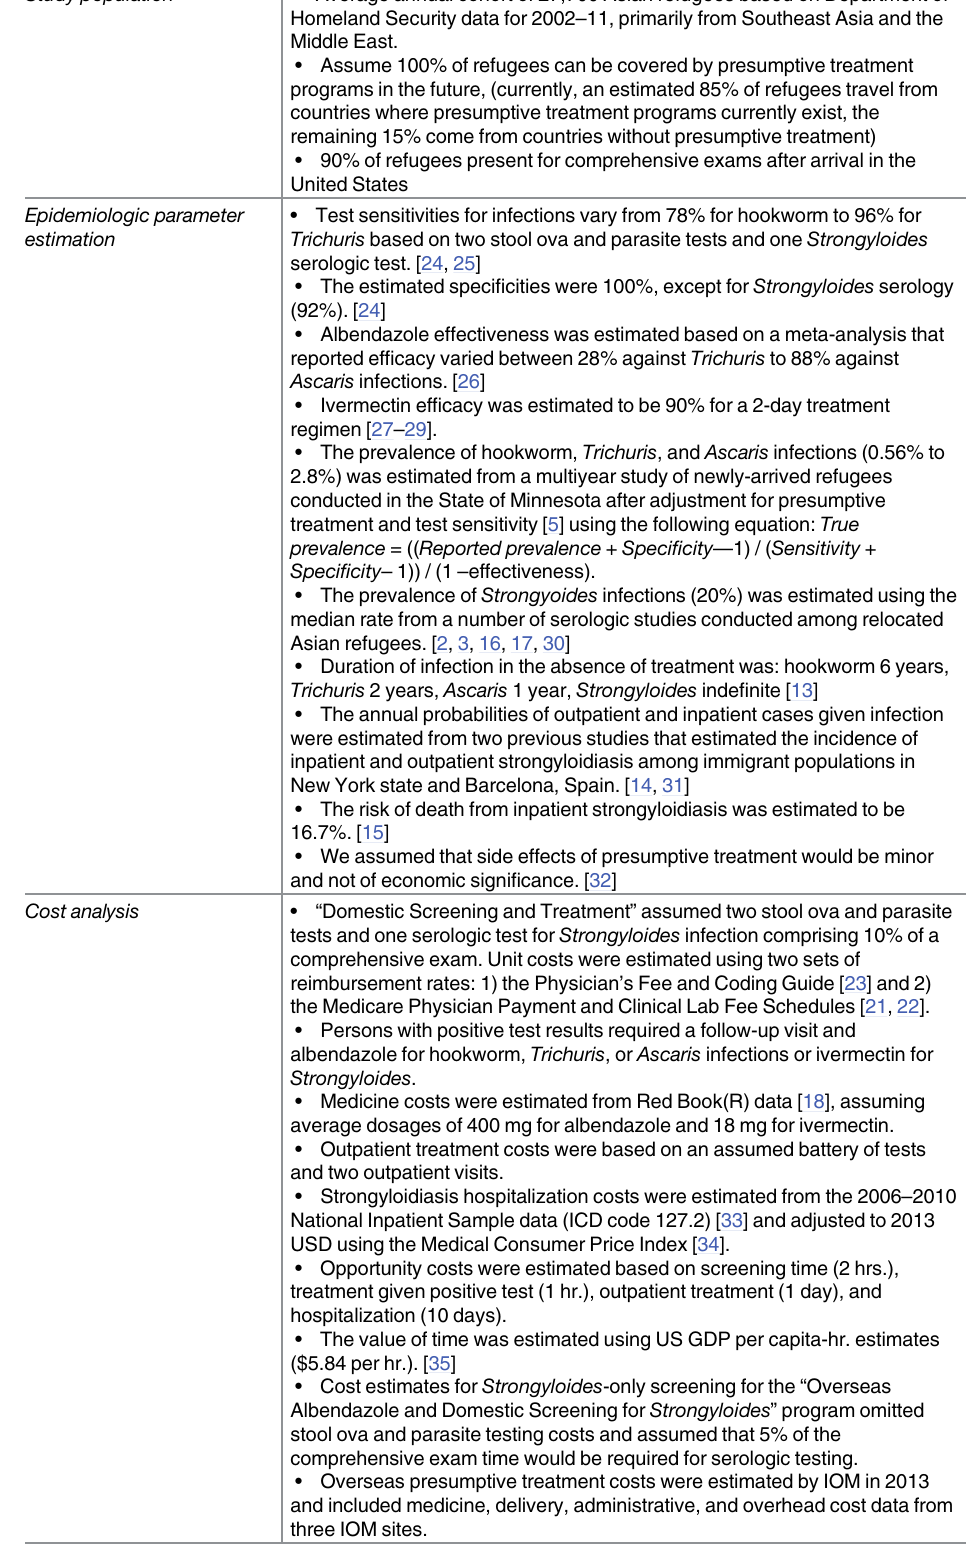
Table 1. Summary of key epidemiologic, economic, and demographic parameter